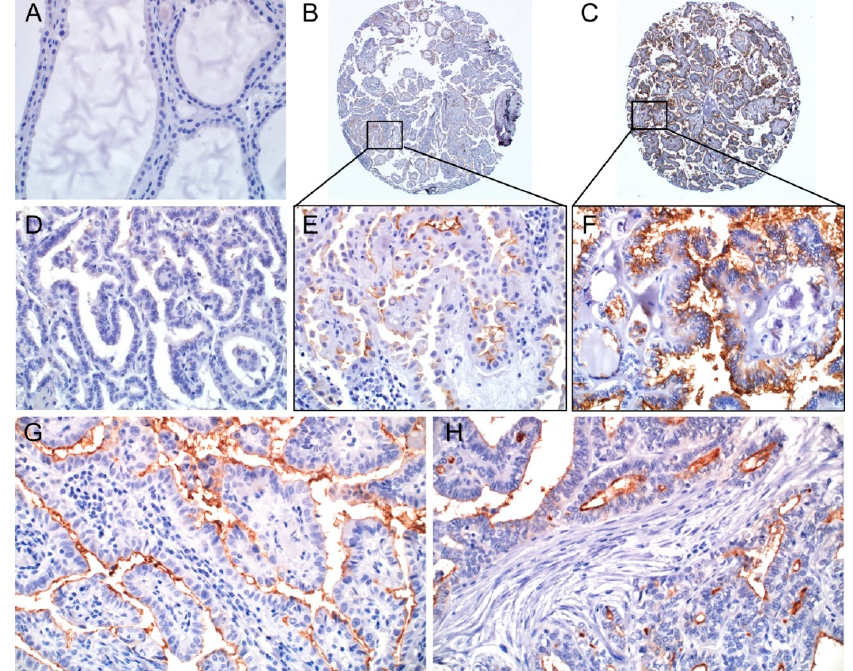
Figure 1. Immunohistochemical expression of CD73 in normal thyroid and papillary thyroid carcinoma (PTC) tumor tissue. ( A ) Normal thyroid tissue is negative for CD73. Tumor cells show positive ( B,C ) or negative ( D ) staining for CD73. ( E ) High ‐ powered view of the rectangular area in the ( B ). Tumor cells show apical membranous staining. ( F ) High ‐ powered view of the rectangular area in the ( C ). Tumor cells showed both membranous and cytoplasmic staining. In another CD73 positive case, inflammatory cells ( G ) and fibroblastic and endothelial cells ( H ) in the stroma are negative for CD73, whereas tumor cells are positive. ×400 ( A , D – H ), ×40 ( B , C ). To investigate the clinicopathologic significance of CD73 expression in PTC, the 511 patients were divided into high ( n = 370) and low ( n = 141) expression groups according to a cut ‐ off value of 10% of CD73 immunostained tumor cells (Table 1). High CD73 expression was significantly associated with female gender ( p = 0.047), aggressive histologic variant ( p = 0.002), extrathyroidal extension ( p < 0.001), gross extrathyroidal extension ( p = 0.010), higher pathologic (p) T category ( p =